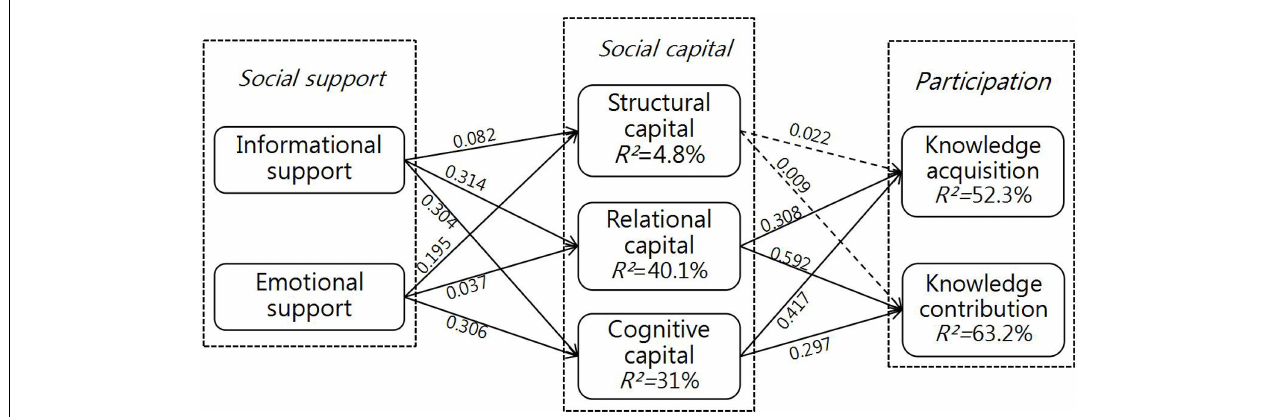
FIGURE 2 | Structural model results. * p < 0.05; ** p < 0.01; *** p < 0.001; the dotted line represents the insignificant